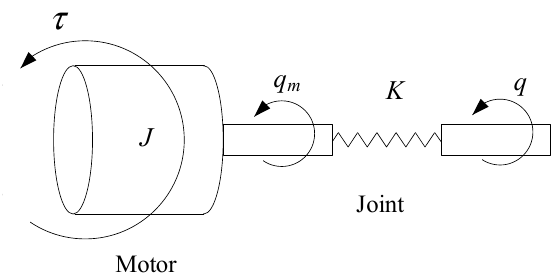
Figure 1. The flexible-joint model of a manipulator. The dynamic model of flexible manipulators studied in this paper is as